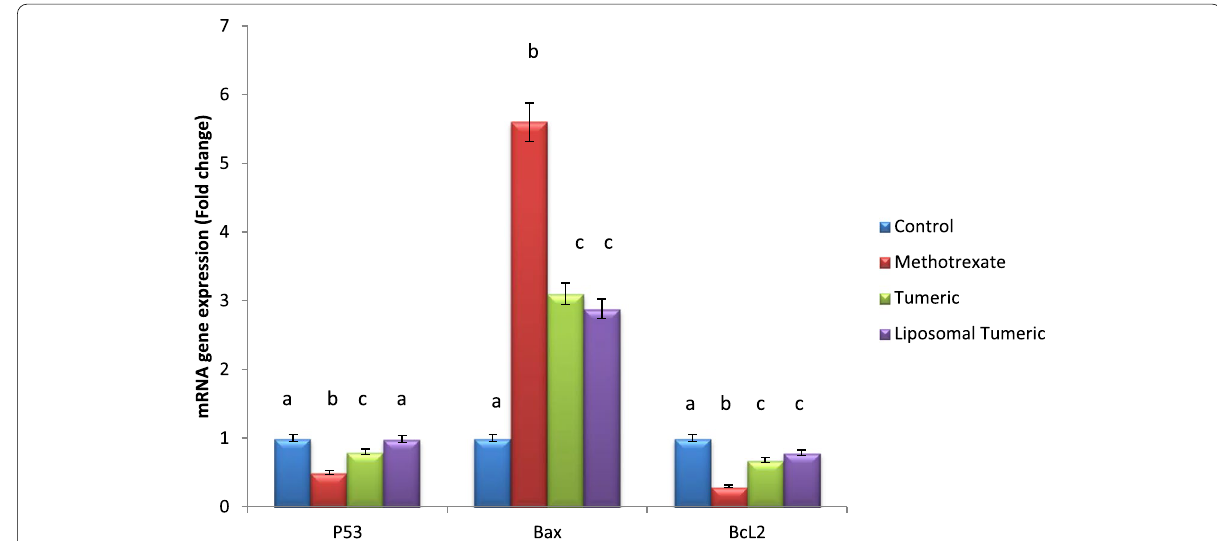
Fig. 4 Impact of turmeric and liposomal turmeric on serum apoptotic markers P53, Bax, and BcL2 gene expression post methotrexate intoxication. GAPDH was used as an internal control for calculating mRNA fold changes. Data are expressed as mean considered significant. Groups having the same letter are not significantly different from each other, while those having different letters are